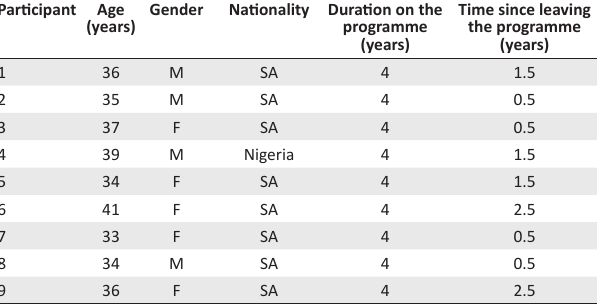
TABLE 1: A summary of student participants’ demographics. Participant Age Gender (years)